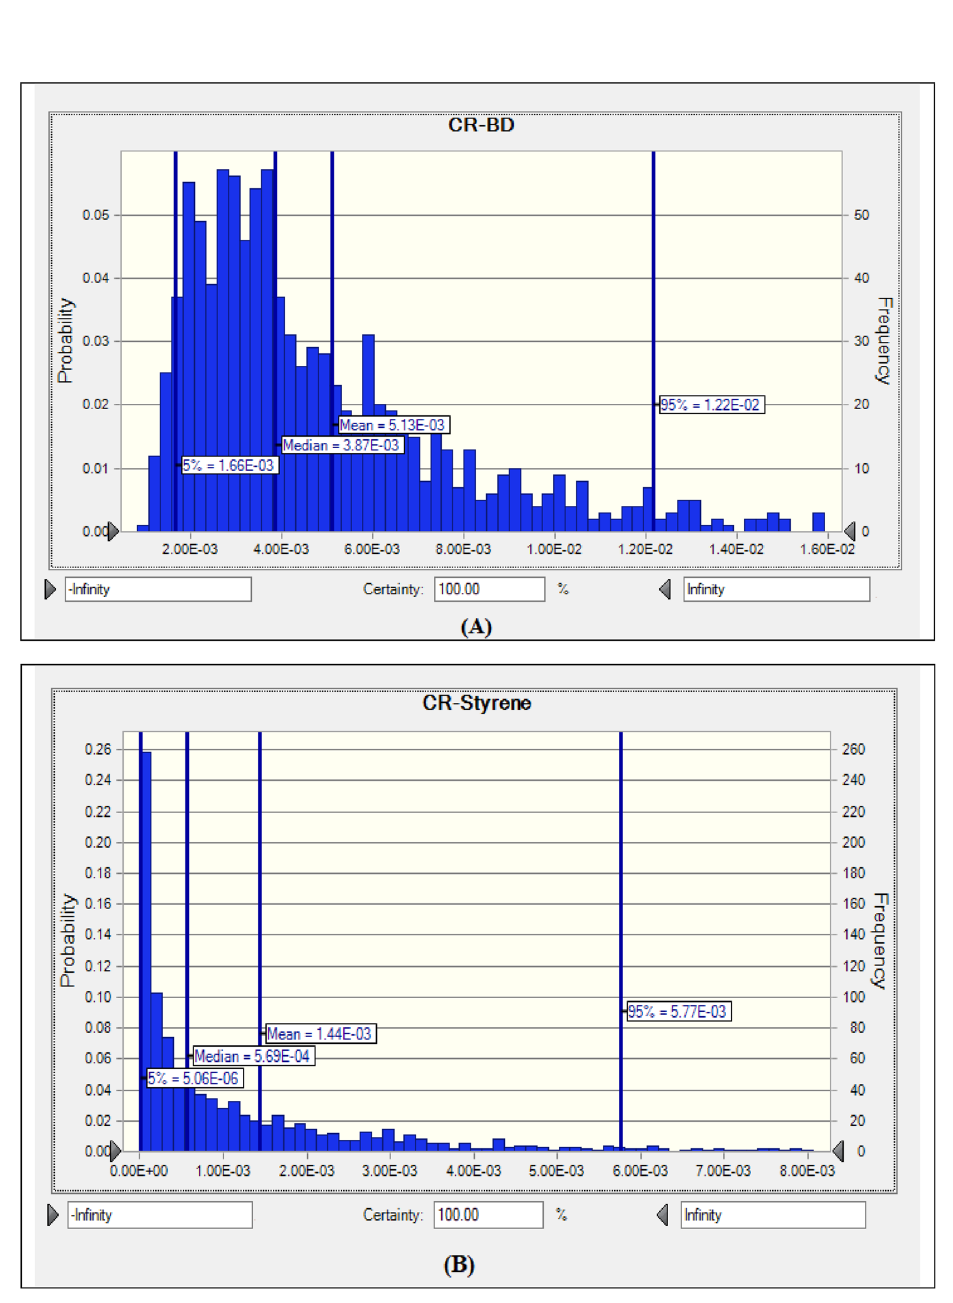
Figure 1. The cancerogenic risk for ( A ) 1,3-butadiene (BD), ( B ) Styrene